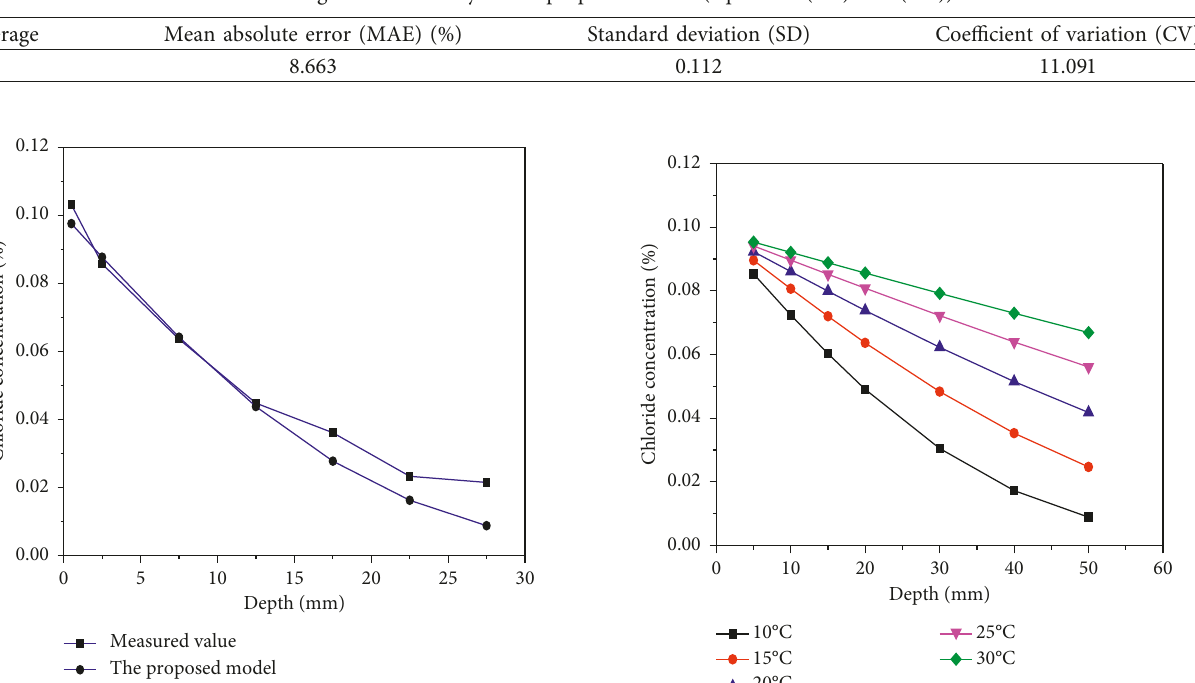
Table 8: Regression accuracy of the proposed model (equations (14a) and (14b)).